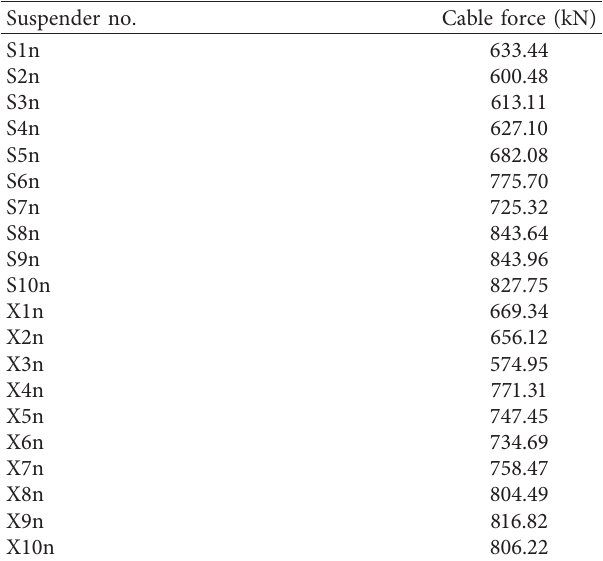
Table 9: Cable forces of some suspenders in previous